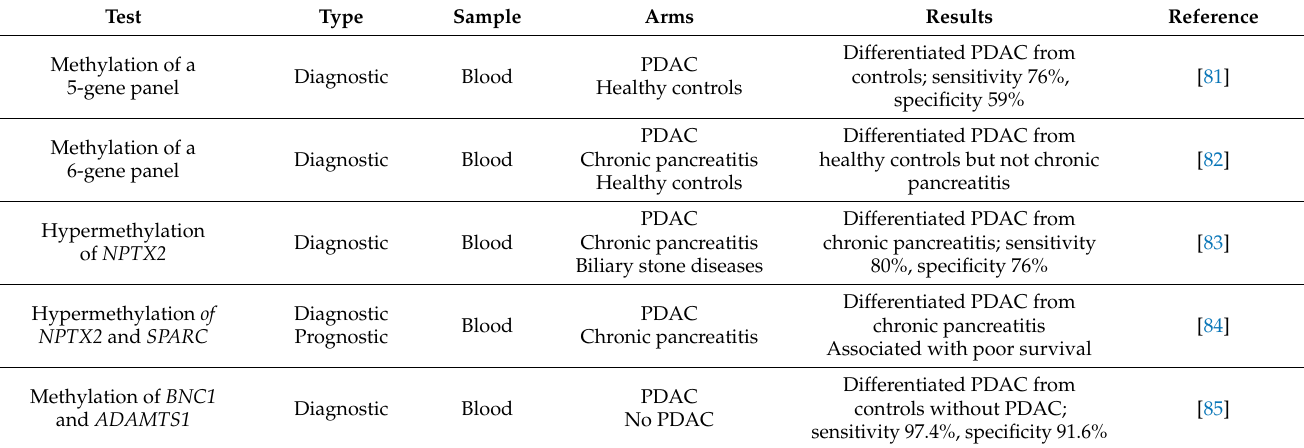
Table 1. Studies assessing the diagnostic utility of potential epigenetic liquid biopsy markers in